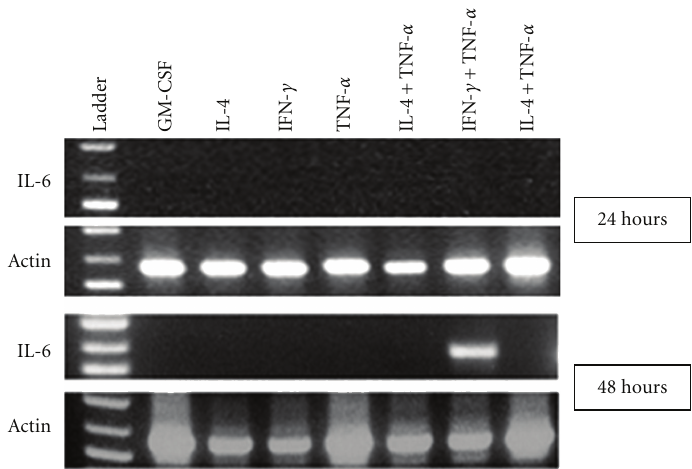
Figure 5: Expression of IL-6 mRNA in cytokine-treated MTHCs: the RT-PCR results show that an IL-6 band is present only in the MTHCs treated with IFN- γ plus TNF- α at 48 hours but not in other treatments. Ladder: DNA